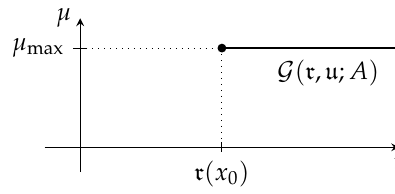
Figure 2. Illustration for the proof of Lemma